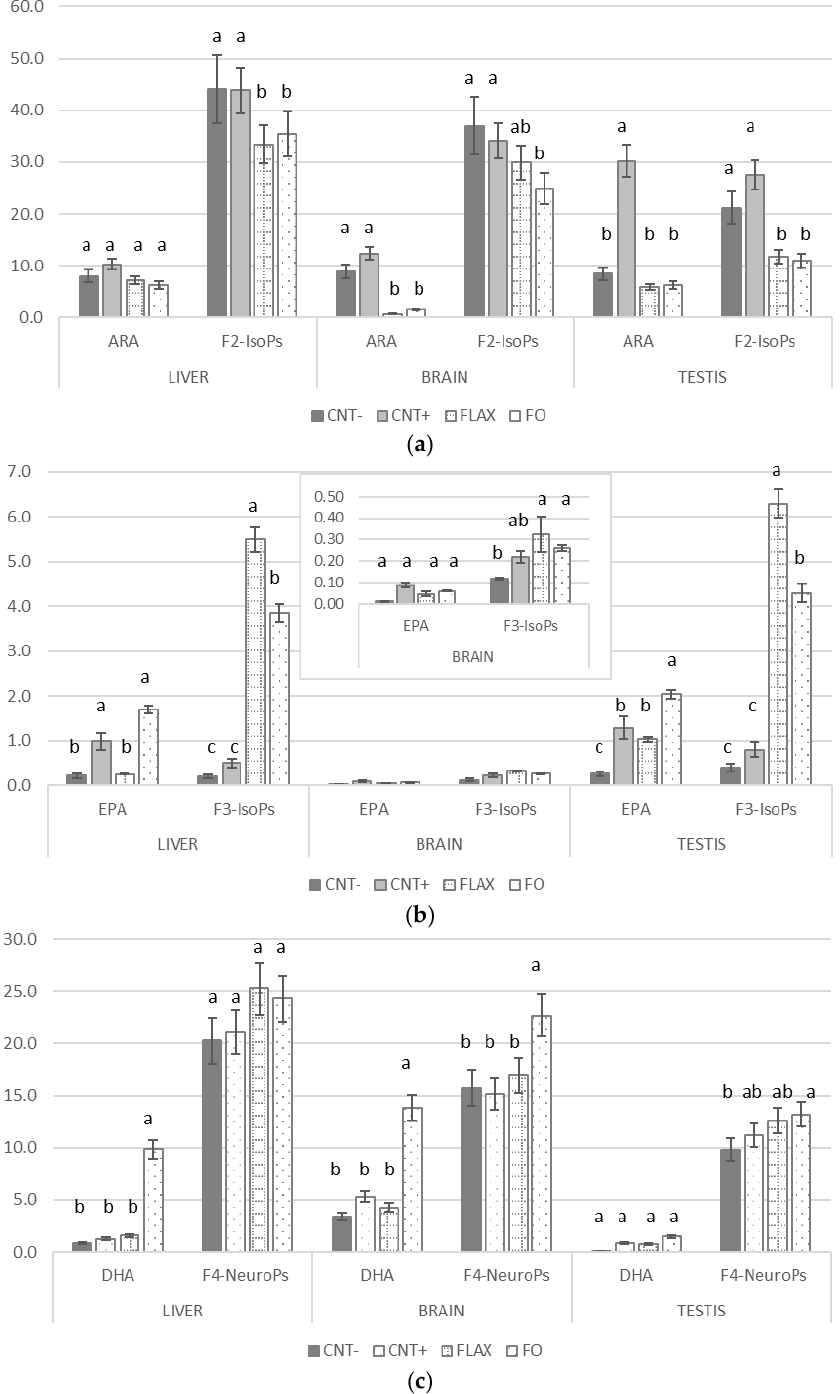
Figure 6. The effect of experimental diets on fatty acid (FA) precursors (arachidonic acid [ARA], eicosapentaenoic acid [EPA], docosahexaenoic acid [DHA]; % of total FA) of isoprostanoids (IsoPs, pg/mL) in rabbit liver, brain, and testis for ( a ) F2-IsoPs, ( b ) F3-isoPs, and ( c ) F4-NeuroPs. When values differences were too wide for showing a complete graph, a support window was added to the main one. The bars represent least squares means + 95% upper and lower limits. a–c indicate a significant difference between dietary groups ( p < 0.05, Bonferroni post-hoc